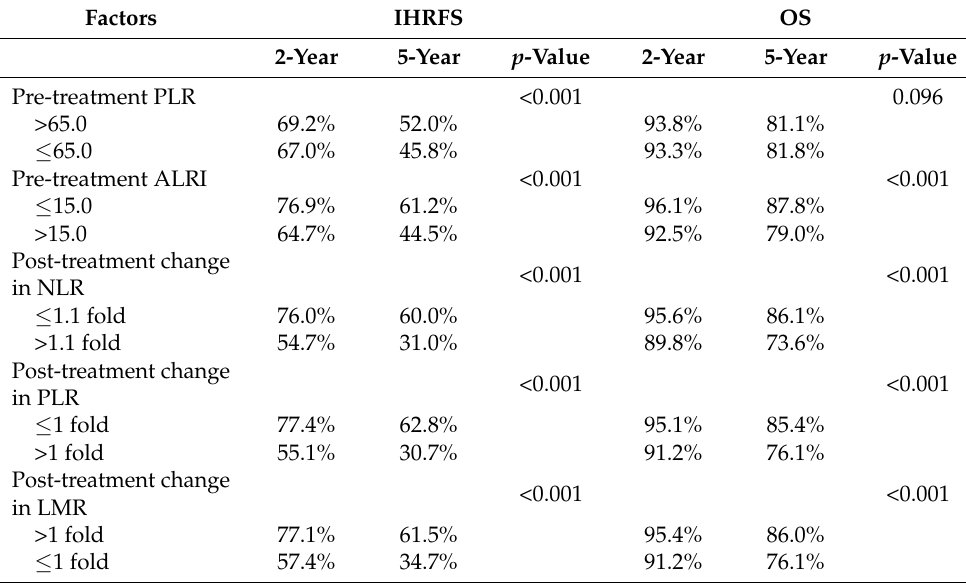
Table 4. IHRFS and OS of patients categorized by